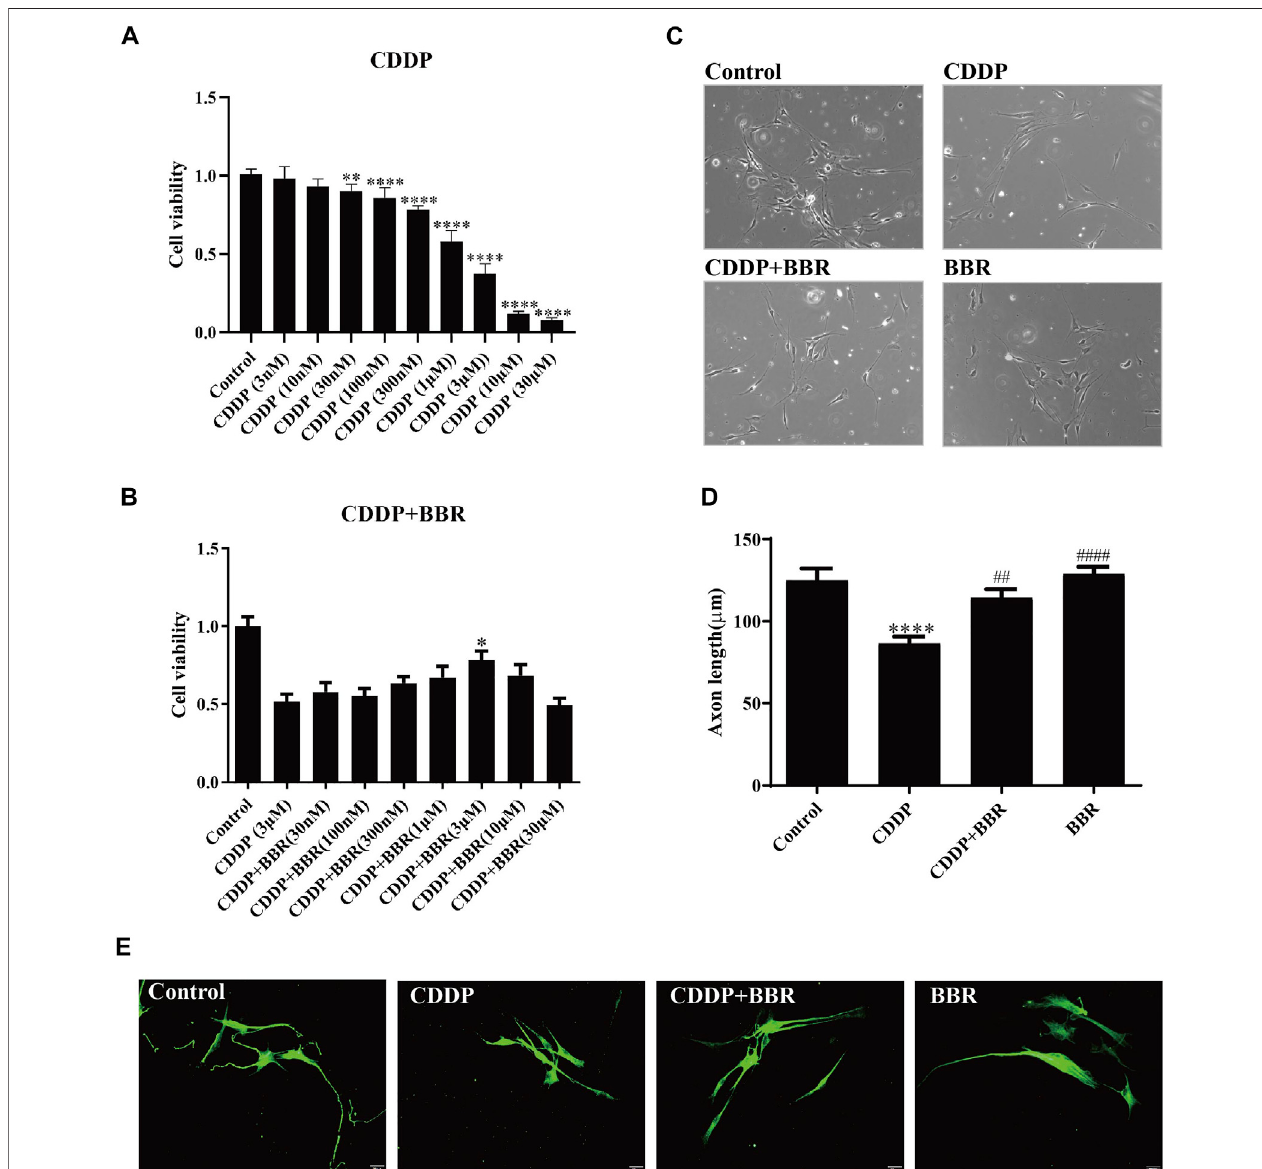
FIGURE 8 | BBR protects DRG cells from damage induced by CDDP. (A) The MTT assay was used to measure the survival rate of neurons. DRG neurons were cultured with CDDP (3 µM) for 48 h, the cell viabilitywasdecreased to40 – 50% ( n (cid:1) 6, F (cid:1) 301.7, p < 0.0001). (B) An injury model ofneurons cultured with CDDP (3 μ M) was established, and then DRG was cultured with different concentration gradient BBR for 48 h. The results showed that BBR (3 μ M) enhanced cell viability ( F (cid:1) 8.034, p < 0.0001). (C) Primary DRG neuronal cell were cultured with CDDP (3 µM). (D) CDDP (3 μ M) contributes to the axon growth, whereas BBR (3 μ M) co-incubated with CDDP protected normal axon growth in neurons or BBR (3 µM) for 48 h ( F (cid:1) 13.59, p < 0.0001). (E) Neuron speci fi c nucleoprotein β III-tubulin staining was used to identifyprimaryDRGcellaxons.BBR(3 μ M)attenuatesthedamageofCCDPtoprimaryDRGcells.Statisticalanalysiswasperformedusingone-wayANOVA(* p <